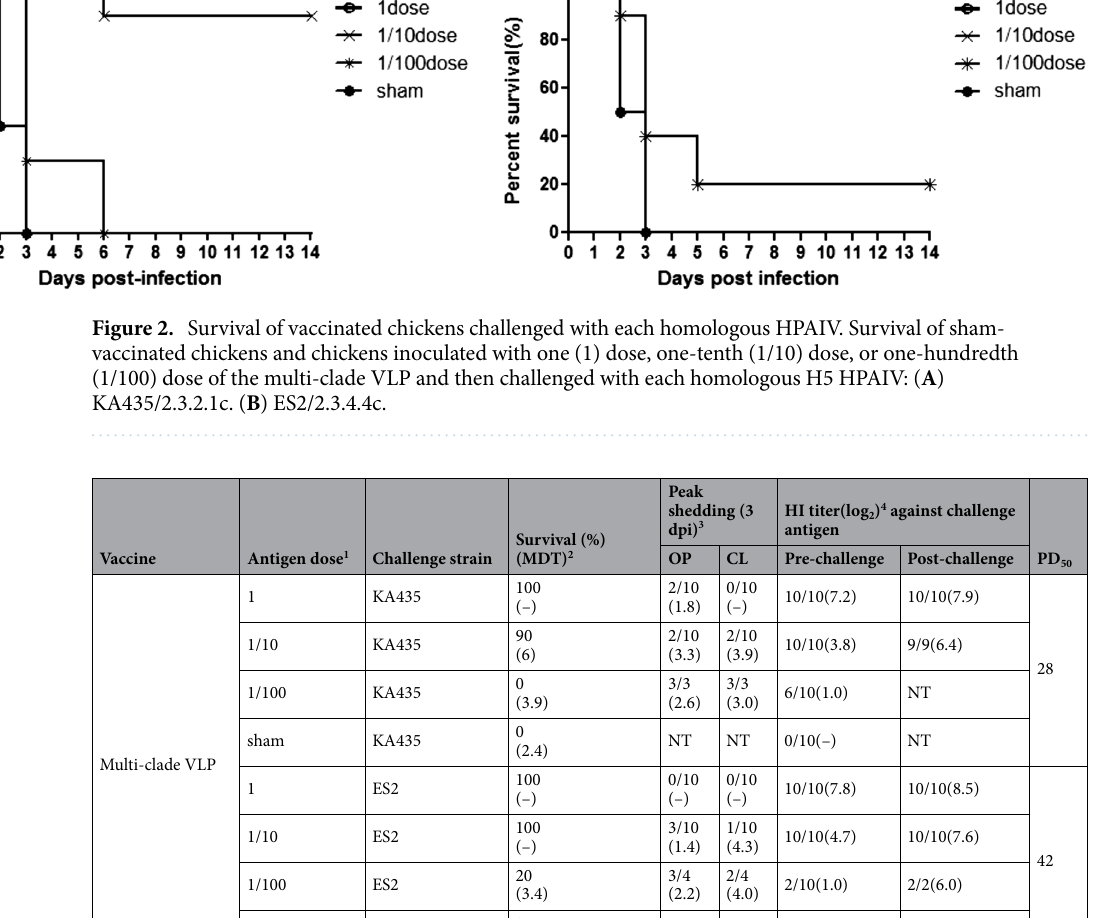
Table 3. Results of vaccination with varying doses of multi-clade VLP against two homologous HPAI. HA hemagglutination activity, NT not tested, dpi days post-infection, OP oropharyngeal, CL cloacal, HI hemagglutination inhibition, PD 50 protective dose 50% *p value < 0.05. 1 One dose (1) contained 512 HAU (hemagglutination units). 2 MDT, mean death time (days). 3 No. of virus positive/total in the group (mean shed- virus titer). 4 No. of serology positive/total surviving in the group (mean HI titer).